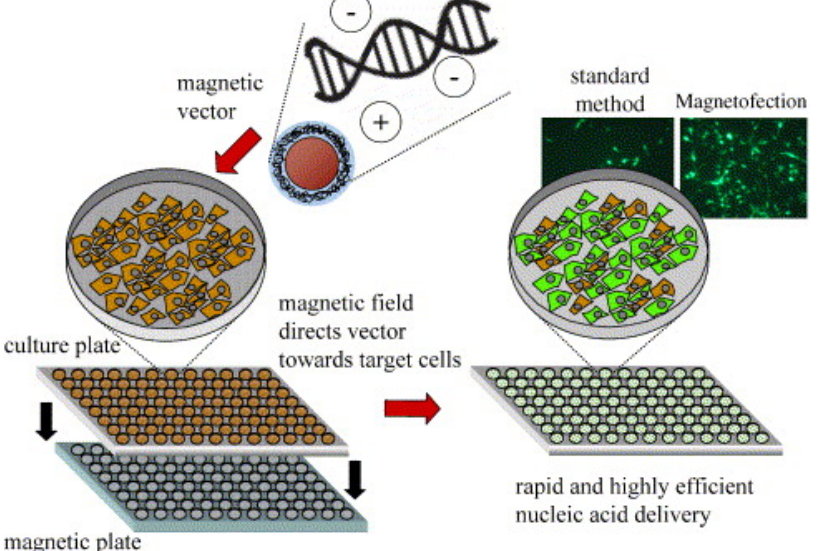
Figure 1. Principle of magnetofection in cell culture. Polyelectrolyte-coated magnetic nanoparticles are mixed with naked nucleic acids or synthetic or viral nucleic acid vectors in salt containing a buffer. The particles associate with the nucleic acids and vectors by electrostatic interaction and/or salt-induced colloid aggregation. The mixtures are added to cells in culture. The cell culture plate is positioned on a magnetic plate during 5–30 min of incubation. The magnetic plate consists of 96 individual neodymium–iron–boron magnets inserted in drill holes in an acrylic glass or PVC (polyvinyl chloride) plate in a strictly alternating polarization. The magnetic field rapidly sediments vectors on the cells to be transfected/transduced. The result is rapid kinetics and high-efficiency nucleic acid delivery. Adapted with permission from [52]. Copyright Elsevier, 2005.